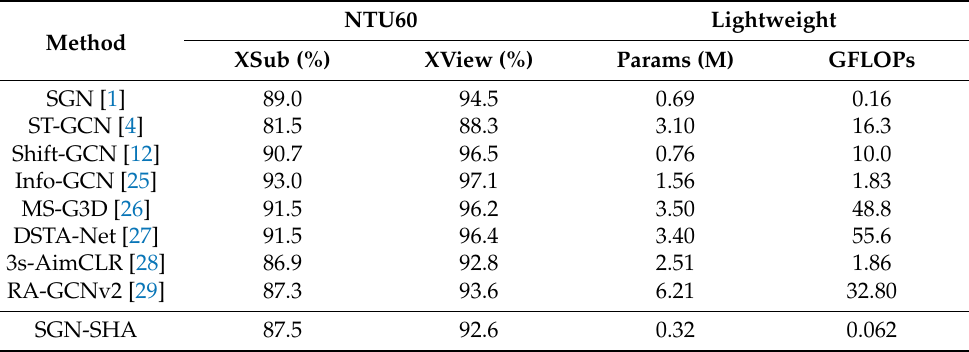
Table 1. Accuracy, the numbers of parameters (Params, M: Million) and computation complexity (Giga FLoating point Operation Per Second: GFLOPs) between SoTA methods and the proposed approach on the NTU60 dataset.